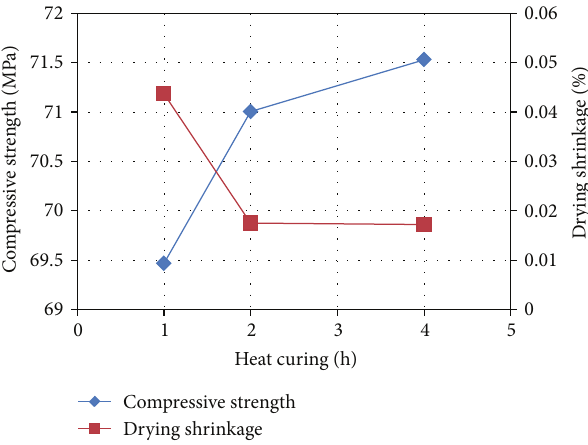
Figure5:DryingshrinkageofgeopolymermortarscontainingOPA, heat cured for 2 hours.